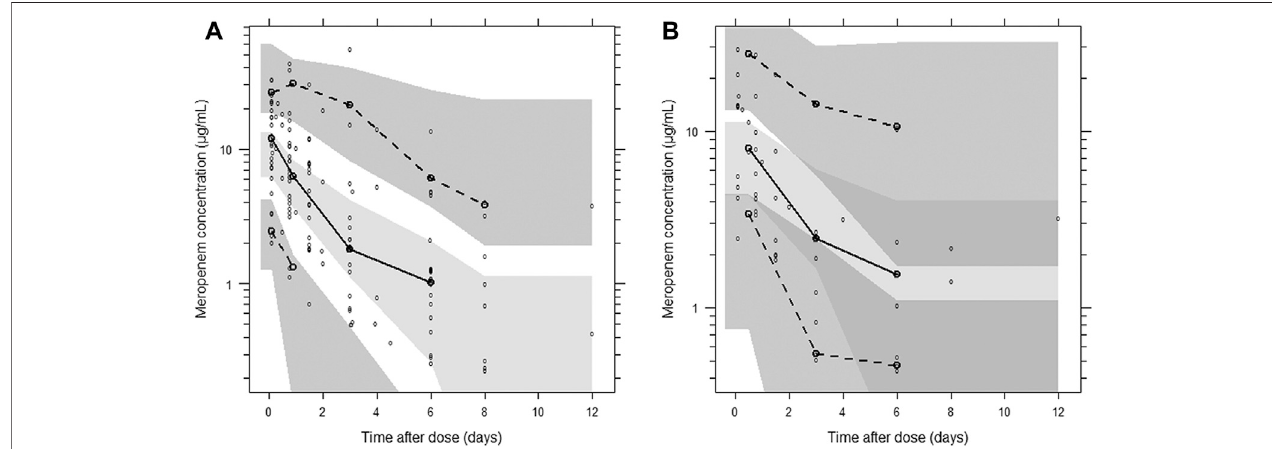
FIGURE3| Visualpredictivecheckofthe fi nalpopulationpharmacokineticmodelformeropenem. (A) Plasmaconcentration; (B) post-CRRTconcentration.Based on1,000stochasticsimulations.Opencirclesrepresent theobservations,andsolidlinesrepresentthe5th,50th,and95thpercentilesoftheobserveddata.Theshaded areas represent the 95% con fi dence intervals around the simulated 5th, 50th, and 95th